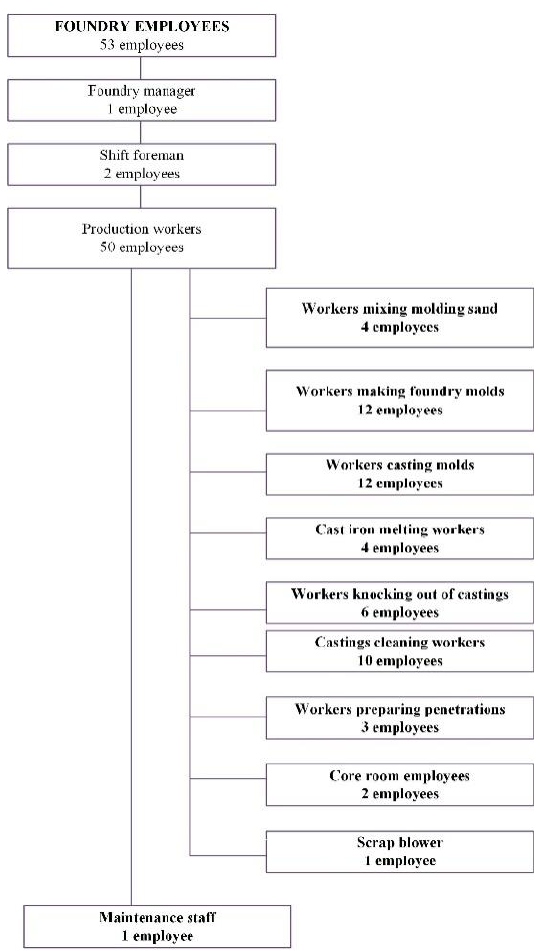
Figure 5. Foundry's employment structure. Figure 5. Foundry’s employment